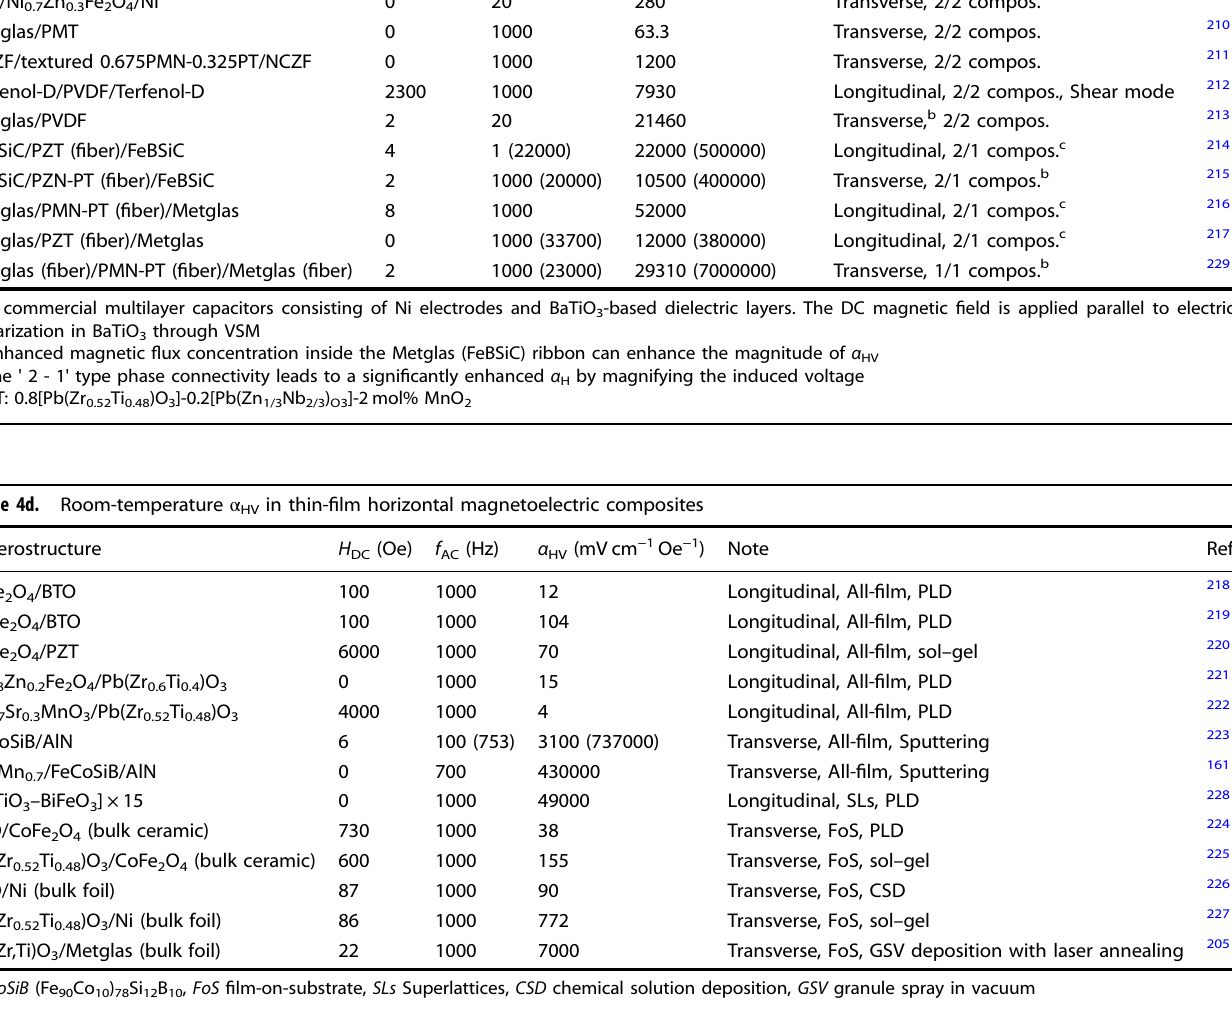
Table 4c. Room-temperature α HV in bulk horizontal magnetoelectric composites Heterostructure Ref.